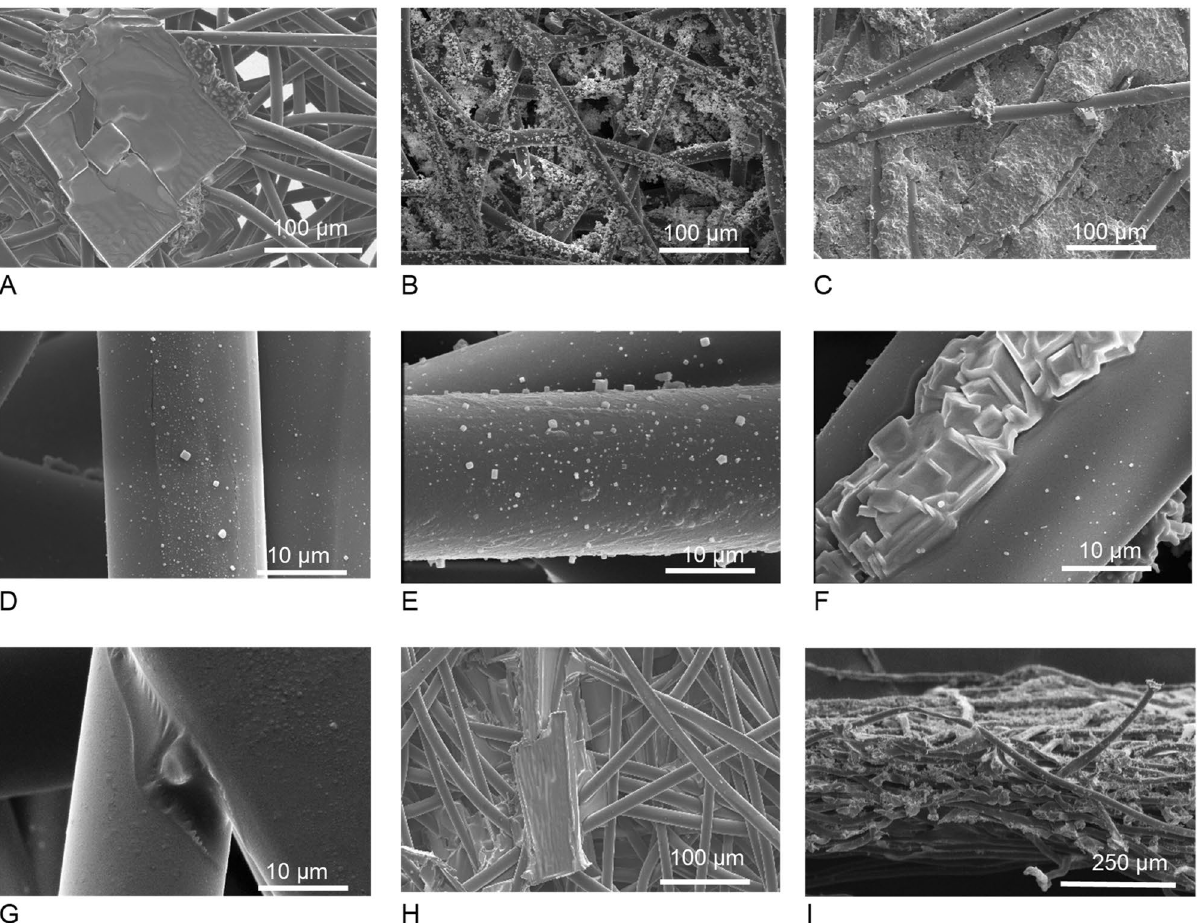
Figure 2. Crystal size and coverage ( A ) For a 5 mg/cm 2 drop-cast; ( B ) a 5 mg/cm 2 nebulized coating ( C )